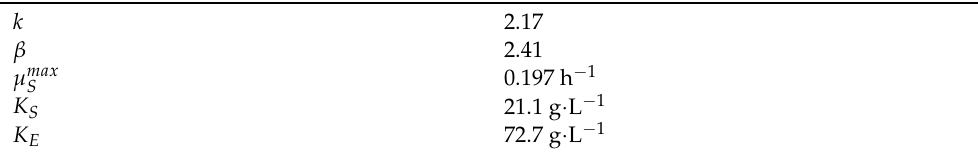
Table 4. Parameters for the second step S → E + CO 2